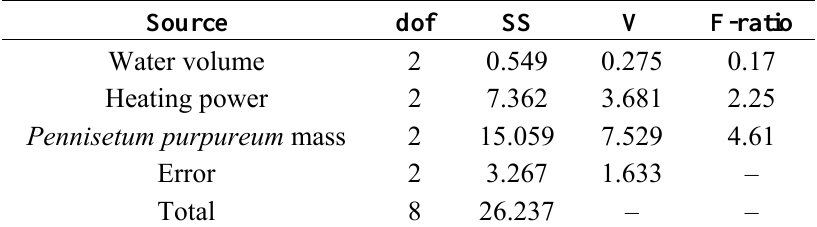
Table 4. Analysis of Variance (ANOVA).